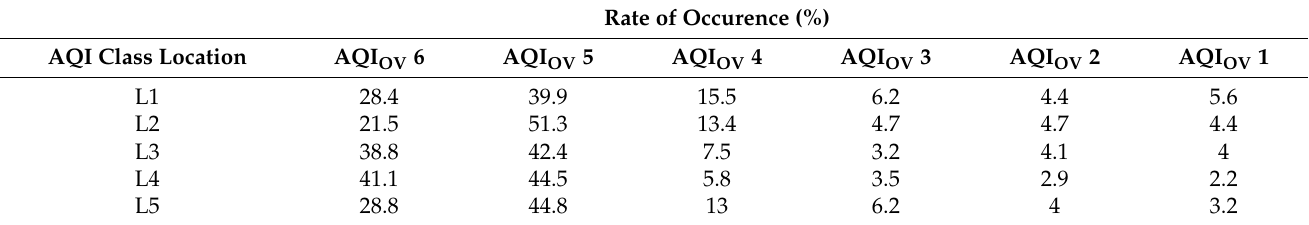
Table 3. Occurrence rates of overall air quality index classes at locations